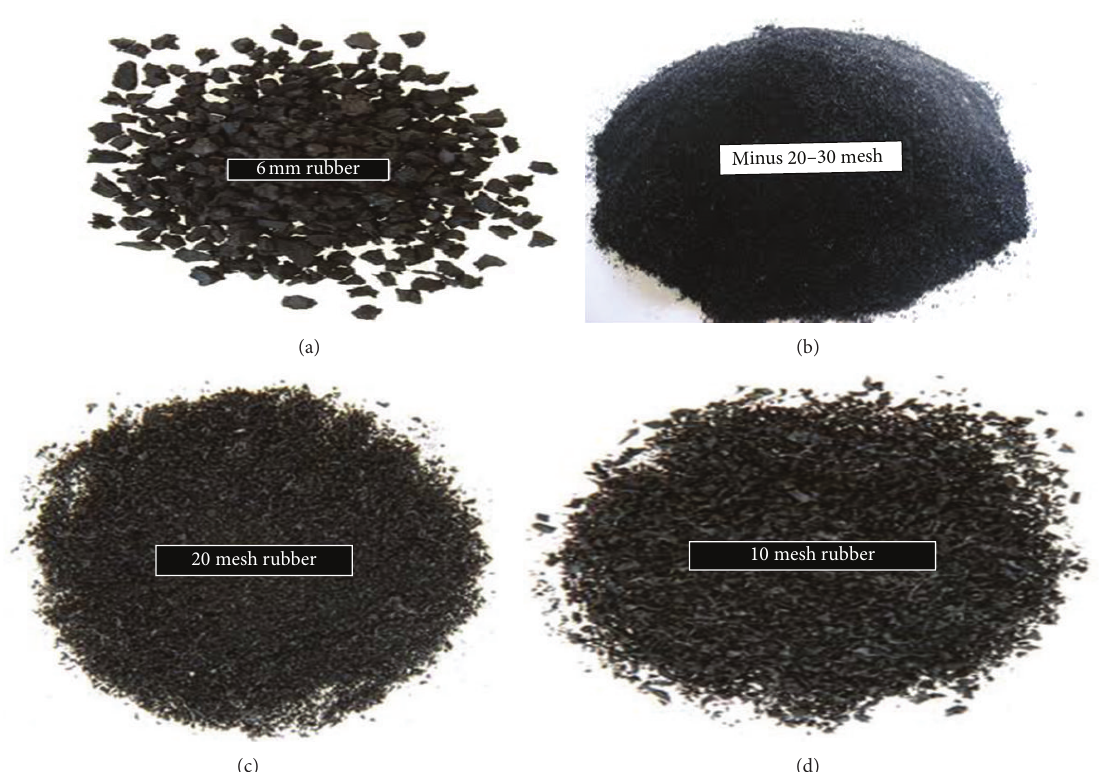
Figure 9: Different type of crumb rubber based on particle